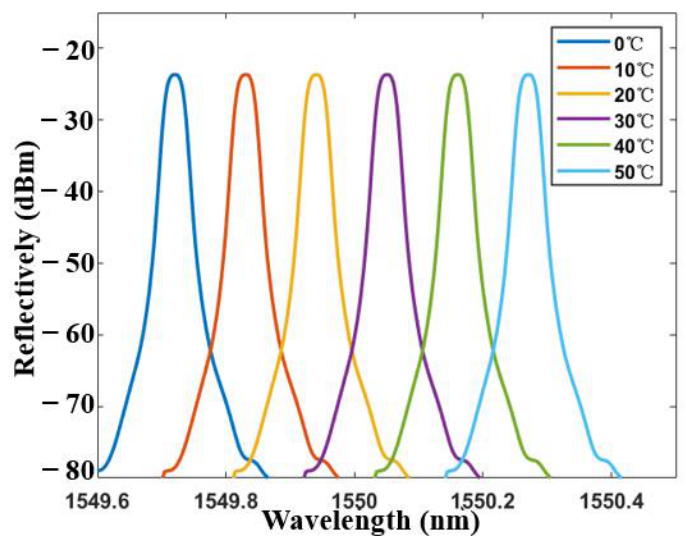
Figure 12. Transmission spectra of the tFBG at different temperature.